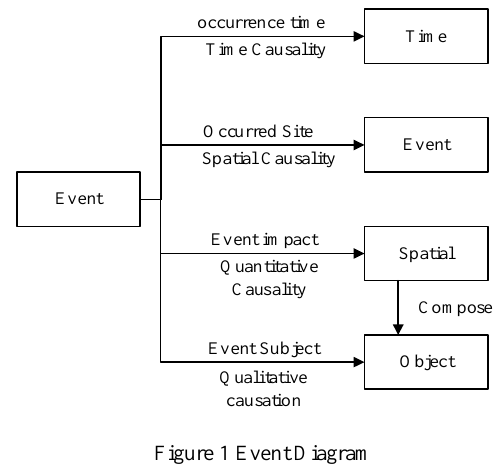
Figure 3 Event-based spatiotemporal data